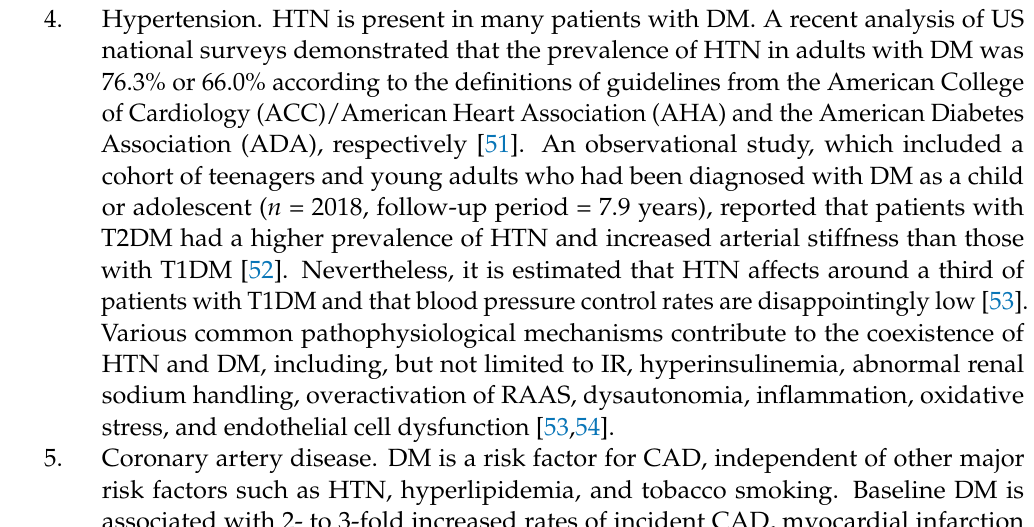
Figure 5. Early cardiac changes in morphology and function related to diabetes. Diabetes mellitus affects all 4 chambers of the heart. While right ventricular ejection fraction (RVEF) and left ventricular ejection fraction (LVEF) are preserved with no difference between diabetes mellitus and no diabetes mellitus, RV and LV chamber sizes are decreased. This occurs before increase in LV mass can be detected but is represented by an increased LV mass-to-volume ratio, suggesting early cardiac remodeling. Deformation imaging shows subtle impairment in LV function related to diabetes despite similar LVEF. The smaller ventricular volumes are accompanied by smaller right atrium (RA) and left atrium (LA) volumes. For both RA and LA, emptying function is impaired, which may represent an early marker of dysfunction occurring before impairments in LV or RV function. Figure based on data from: Steele, J.M. et al. Cardiovasc Diabetol 2020; 19:163 (Ref. [47]); Jensen, M.T. et al. Circ Cardiovasc Imaging 2019; 12:e009476 (Ref. [49]); Kumric, M., et al. World J Diabetes 2021; 12: 685–705 (Ref.